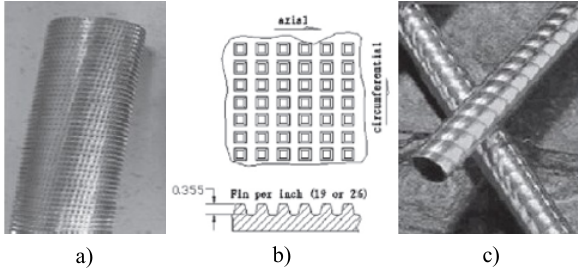
Fig. 2. Characteristics of falling film evaporator investigated by Li et al. [15]; a) Turbo-CAB 19 FPI tube b) Turbo-CAB tube fins, c) Korodense